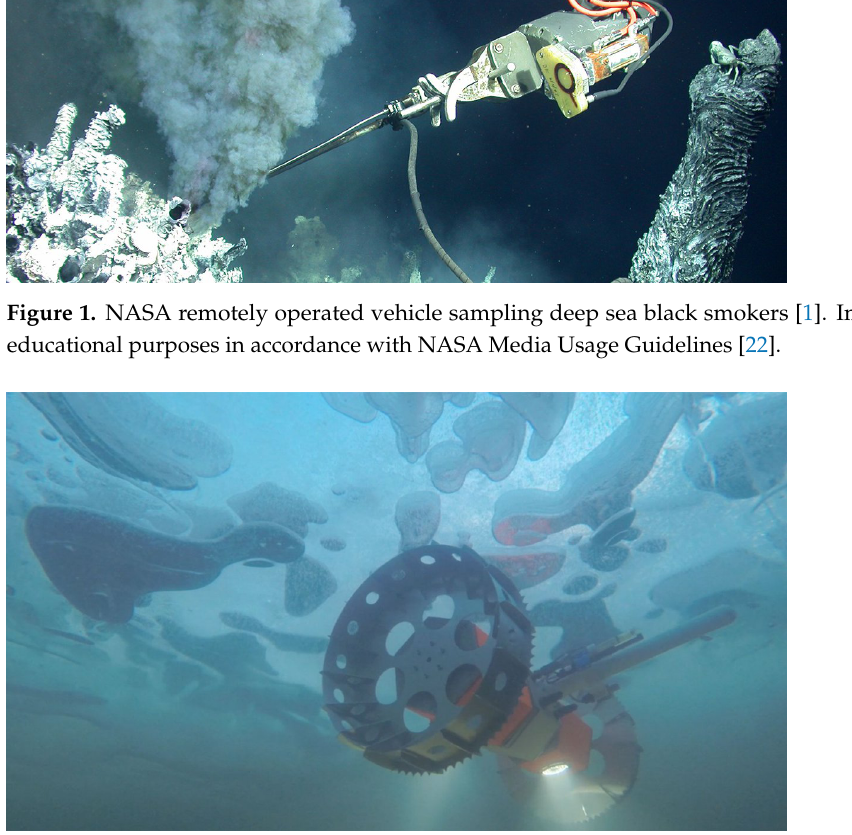
Figure 2. NASA BRUIE under-surface rover designed to explore alien oceans [2]. Image used for educational purposes in accordance with NASA Media Usage Guidelines